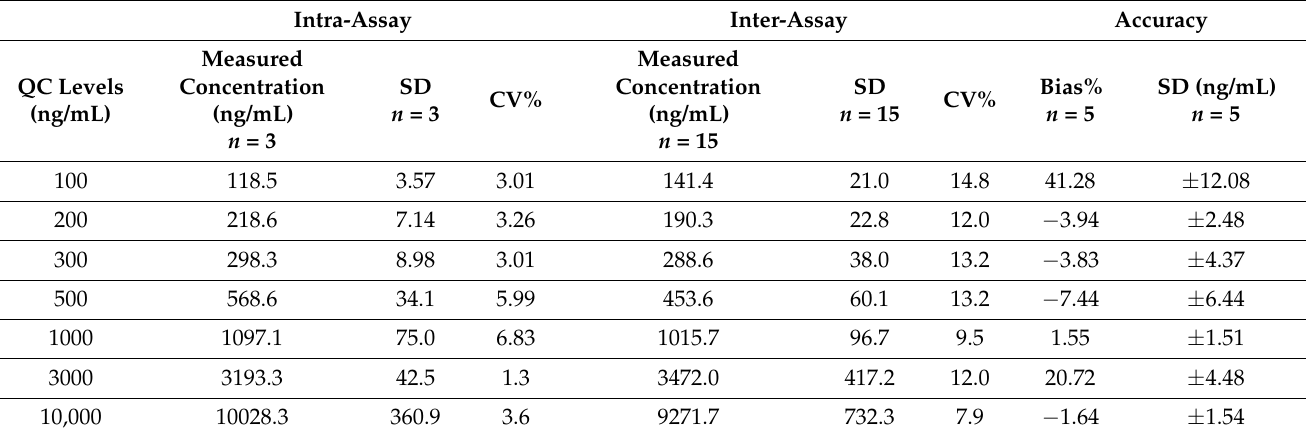
Table 2. Measured concentration (ng/mL), standard deviation (SD) and CV% measured in n = 3 replicates intra-assay and n = 3 replicated for five consecutive days for inter-assay. Accuracy expressed as bias % and SD calculated in n = 5 replicates for each QC IgG